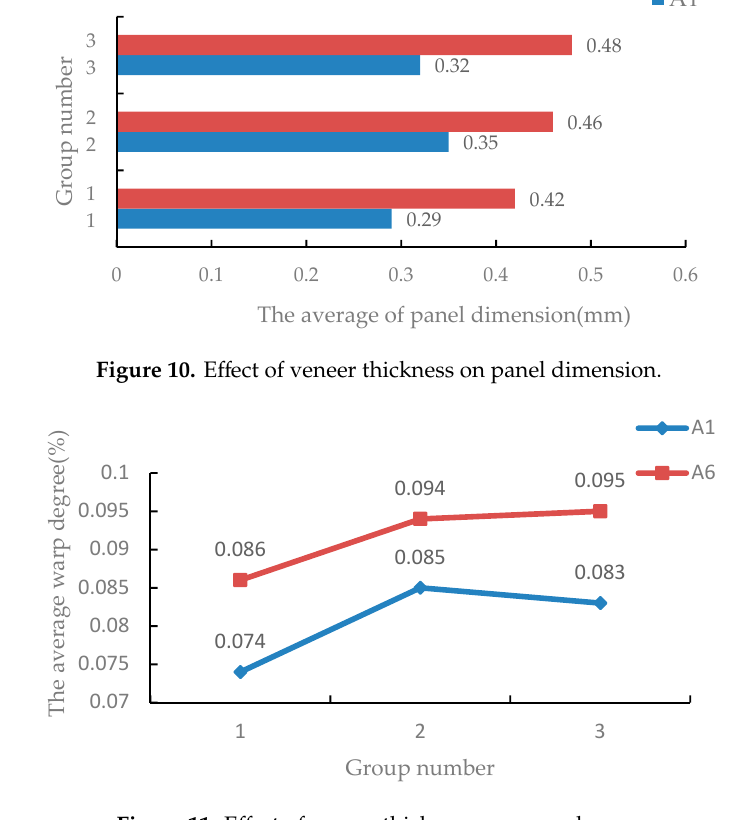
Figure 11. E ff ect of veneer thickness on warp Figure 11. Effect of veneer thickness on warp degree. Figure 11. Effect of veneer thickness on warp degree.